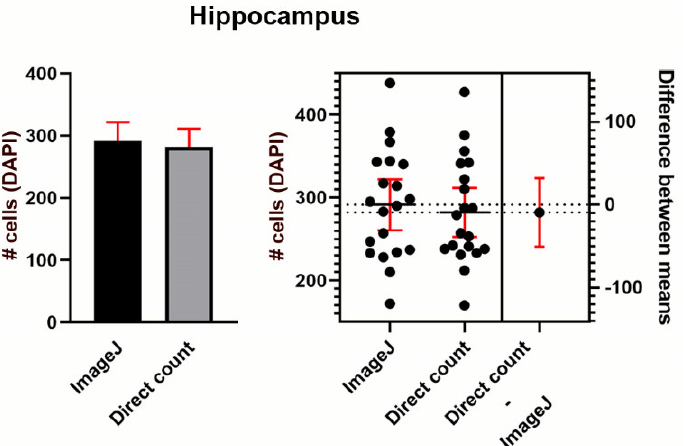
Figure A3. Comparison of automated ImageJ and manual cell count of hippocampal cells shows no statistically significant differences between the results obtained with the two methods. ImageJ 291.3 ± 30, direct count 282.1 ± 28.9. Unpaired t-test. Two-tailed p value 0.6521. The automated counting procedure with ImageJ was as follows: images were converted into binary, and a threshold was applied to clearly distinguish the DAPI+ nuclei from the negative background. The area percentage occupied by the positive signal was calculated and divided by the mean nuclear area calculated for individual granule cells (46 µ 2